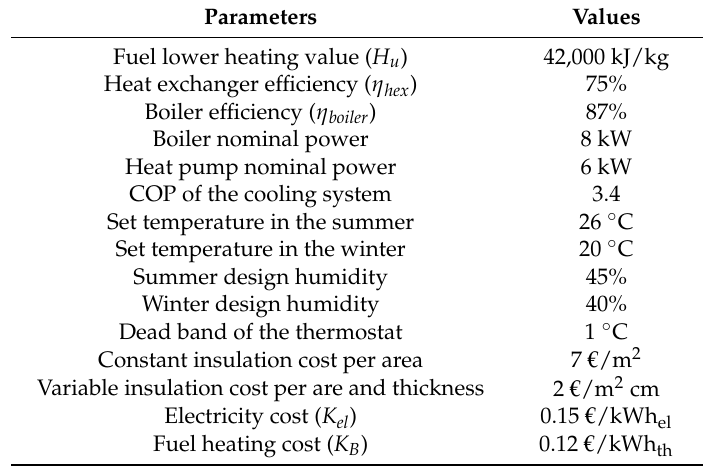
Table 5. Parameters of the examined systems [22,23,34,35]. COP—coefficient of